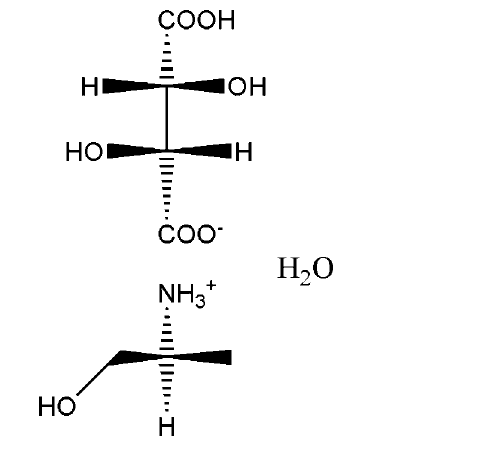
structure: SHELXL97 (Sheldrick, 2008); molecular graphics: SHELXTL (Bruker, 1997); software used to prepare material for publication: SHELXTL